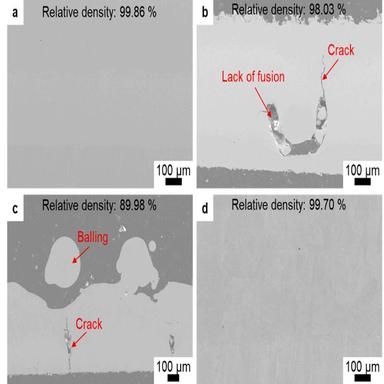
SEM observations of the cross-section of four SS304-IN718-SS304 MMS samples: (a) Case-1; (b) Case-2; (c) Case-3; (d) Case-4.